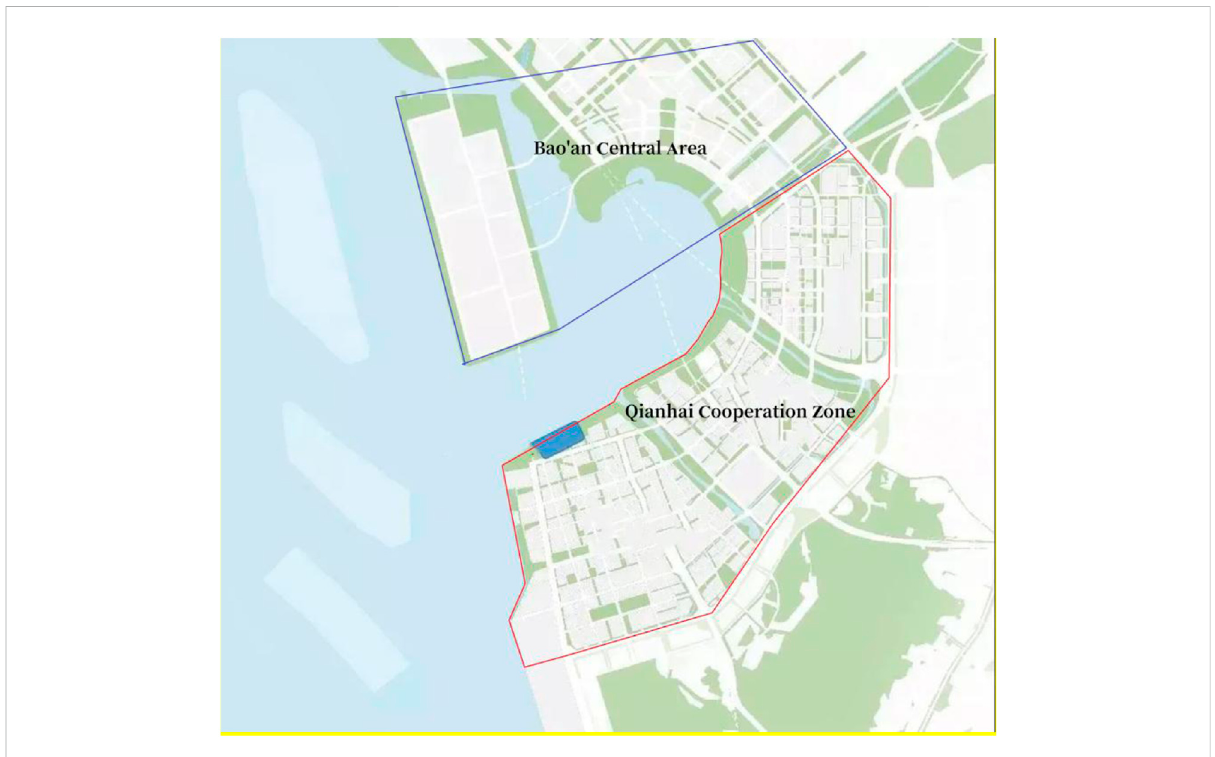
FIGURE 1 Low-carbon urban planning research